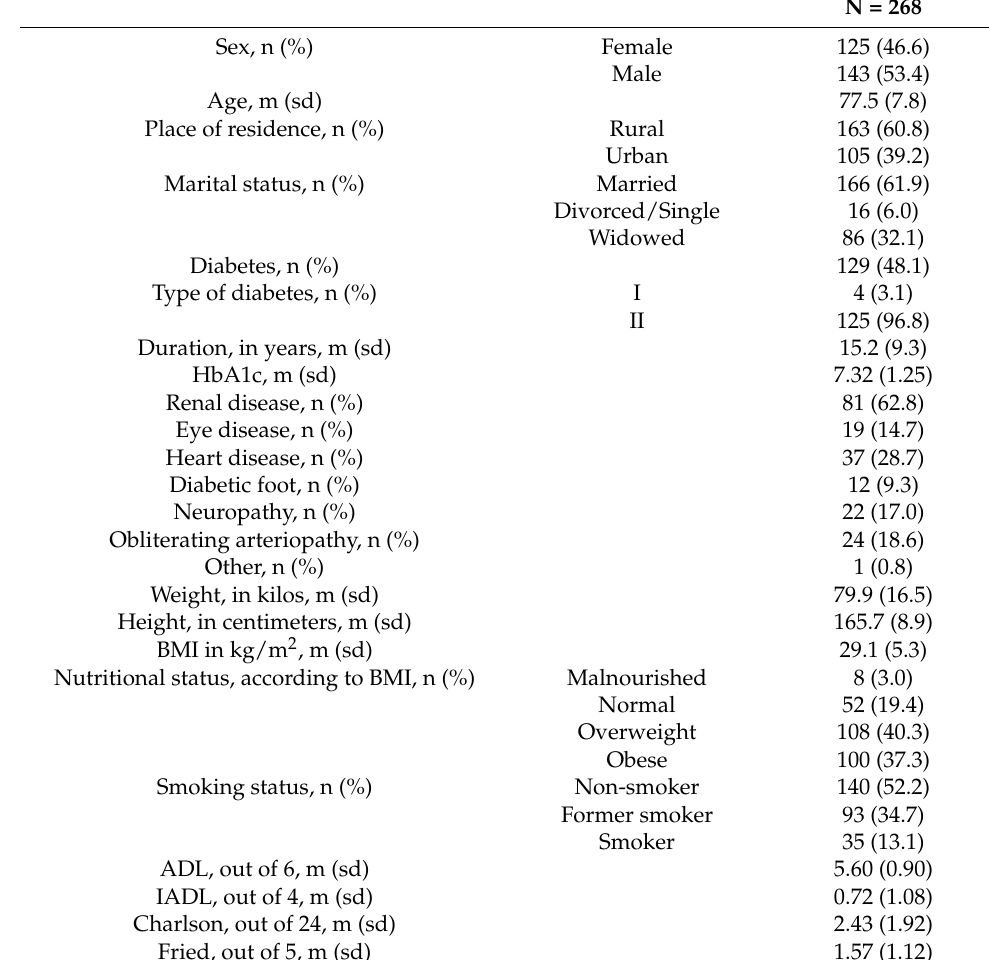
Table 1. Description of the sample